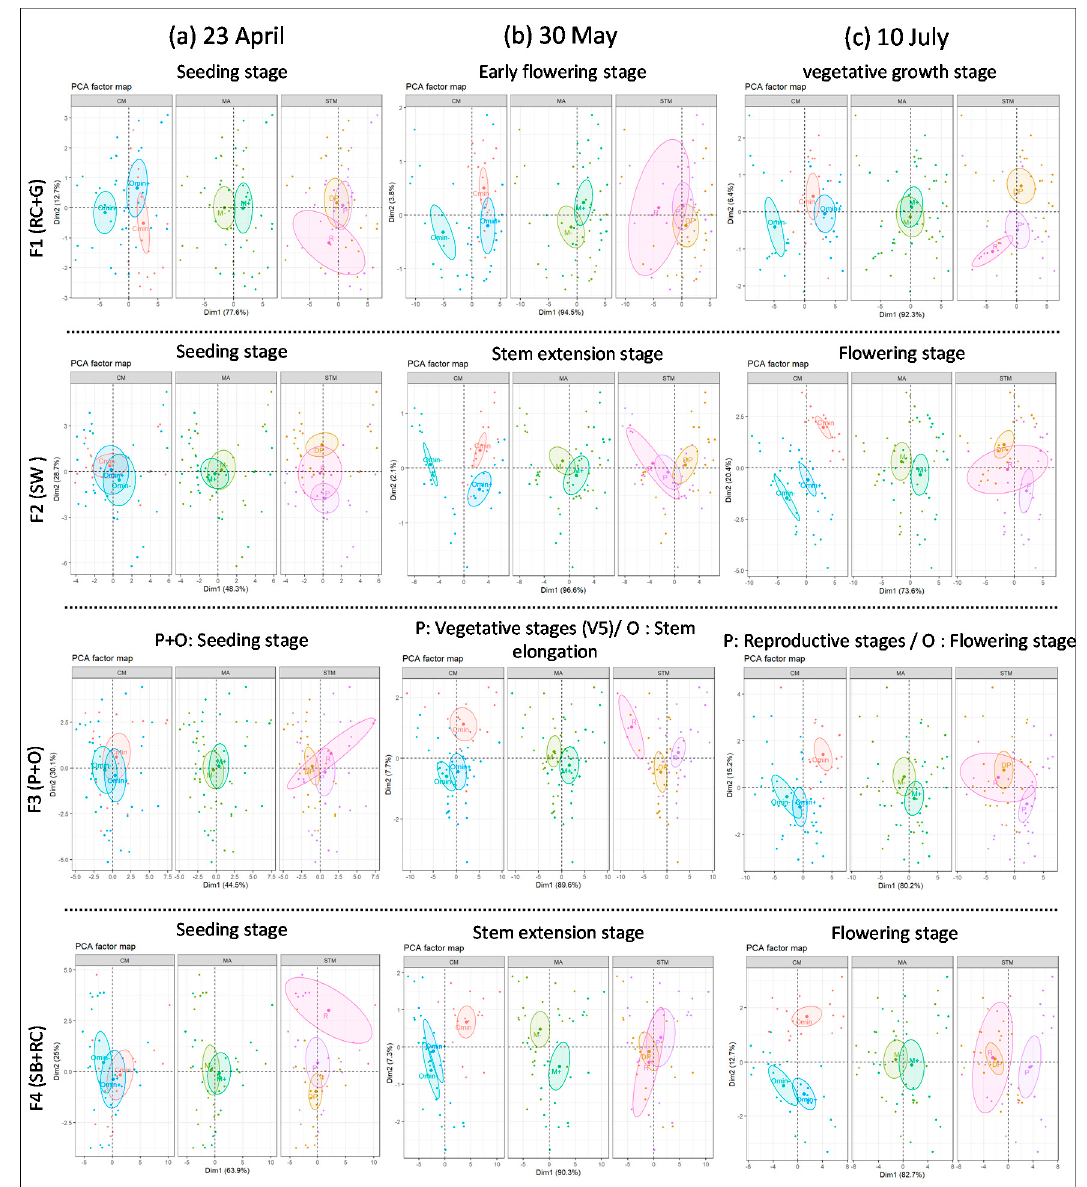
Figure 4. PCA biplot of 19 VI variables (n = 72) of each crop field on ( a ) 23 April, ( b ) 30 May, and ( c ) 10 July. Each biplot shows the PCA individuals (three AMPs) (i.e., CM (Cmin, Omin+, Omin − ), MA (M+, M − ), STM (DP, P, R)) of the first ( x -axis: PC1 score) and second ( y -axis: PC2 score) principal components (the variation explained by the dimensions are shown on the axes); four crop categories (F1–F4) and its corresponding growing stage from top to bottom. Colored concentration ellipses (size determined by a 0.95-probability level) show the observations grouped by marked AMP sub-classes.